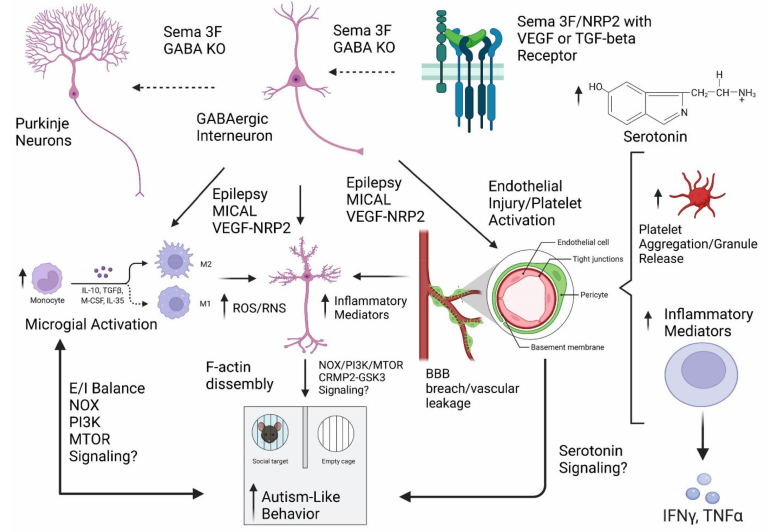
Figure 13. Schematic Representation of Experimental Hypothesis . Neurovascular molecules in- volved in neurodevelopment such as Sema 3F-NRP2 signaling are expressed in microglia,